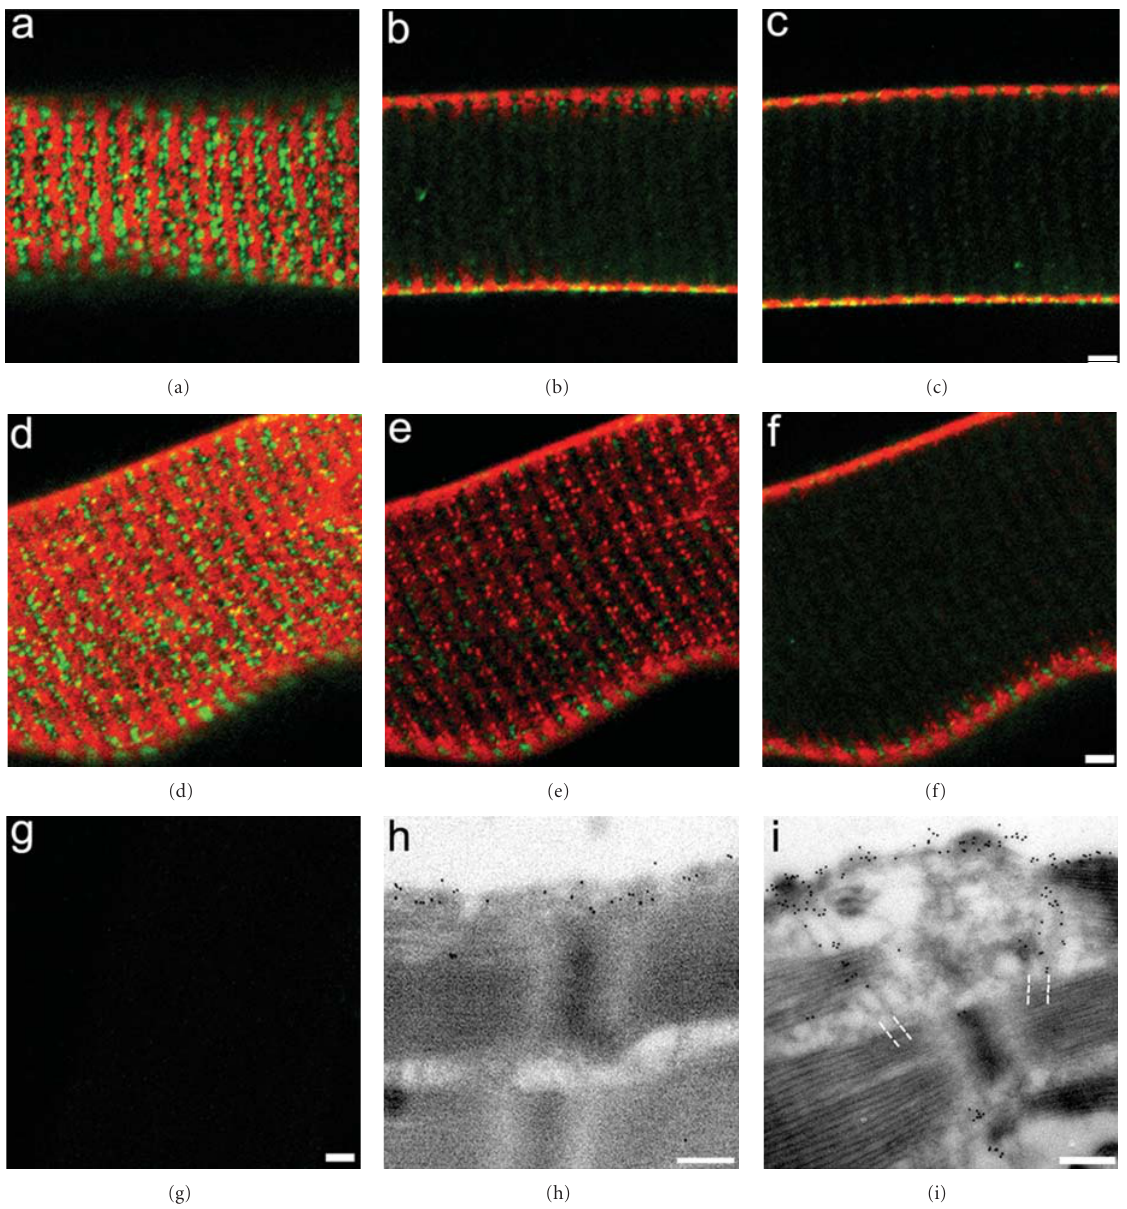
Figure 2: Cav 3 and flotillin 1 reside in di ff erent types of rafts. Cav 3 (red) normally exhibits a cross-striated distribution pattern over the I bands, while flotillin 1 (green) locates to the A-band regions lacking cav 3 (a). A confocal section 5 μ m beneath the sarcolemma shows neither flotillin 1 nor cav 3 (b). A confocal section at the middle of the myofiber shows flotillin and cav 3 on the sarcolemma exclusively (c). After treatment with 5 mM CDX, the sarcolemmal staining patterns retain (d), however, a confocal section 5 μ m beneath the sarcolemma of the CDX-treated myofiber reveals double rows of dots of cav 3 (e). Some subsarcolemmal dots are also visible in the middle section (f). Scale bars, 2 μ m. The flotillin and cav 3 staining patterns were abolished upon omitting the primary antibodies (g). EM immunogold labeling of FDB cryosections shows particles indicating the presence of cav 3 predominantly in the sarcolemma in myofibers not treated with CDX (h). In FDB myofiber treated with 5mM CDX, the immunogold particles are associated with the transverse tubules, marked by dotted lines (i). Scale bar in (h, i) 250